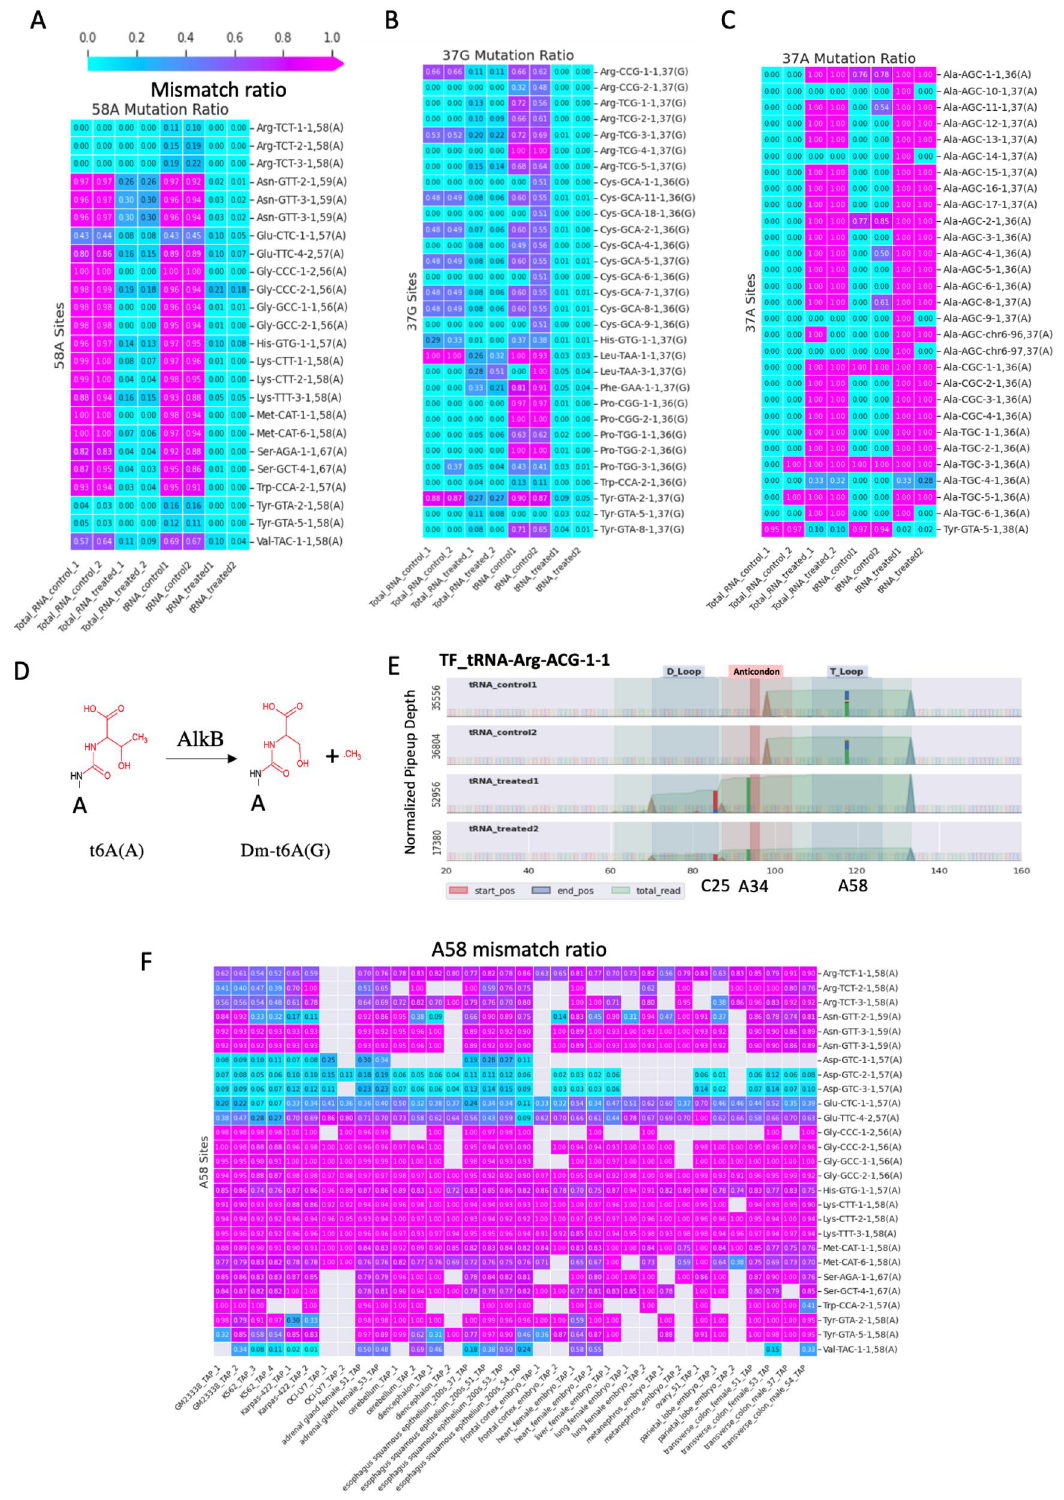
Figure 6. tRNA modifications identified in the DM-tRNA-seq and Cell Lines-Tissues datasets. ( A – C ) Matrixes of mismatch ratios of A58, 37G, and 37A in the DM-tRNA-seq dataset. The mismatch ratios are shown in the units that according to the colors indicated in the legend bar. ( D ) The reaction of methyl group elimination from t6A by AlkB. ( E ) tRF profile of the tRNA-Arg-ACG-1-1 family shows three potential modification sites (C25, A34, and A58). Small bars show the locations and proportion of mismatches. ( F ) The mismatch ratios of A58 of 27 tRNA families in the samples of the Cell Lines-Tissues